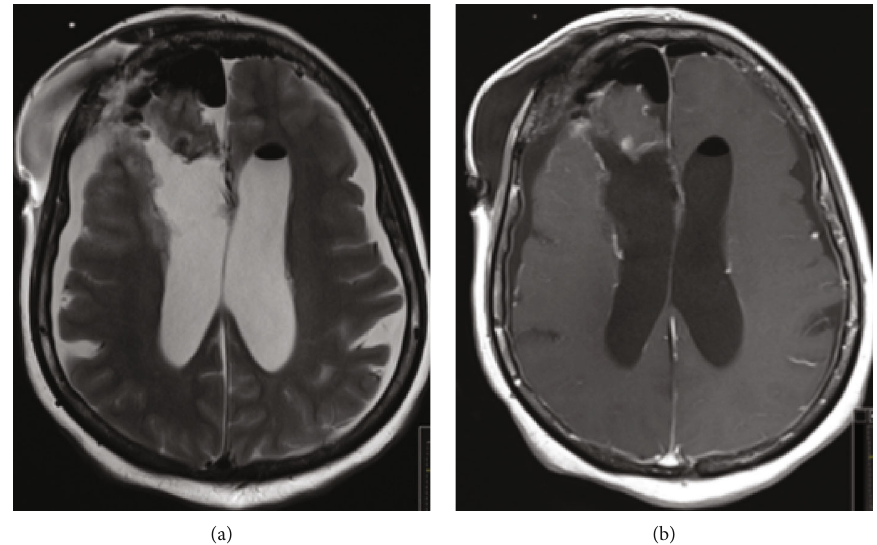
Figure 4: Postoperative axial view of a T2 and T1 with contrast-weighted images, showing total resection of the tumor (a,